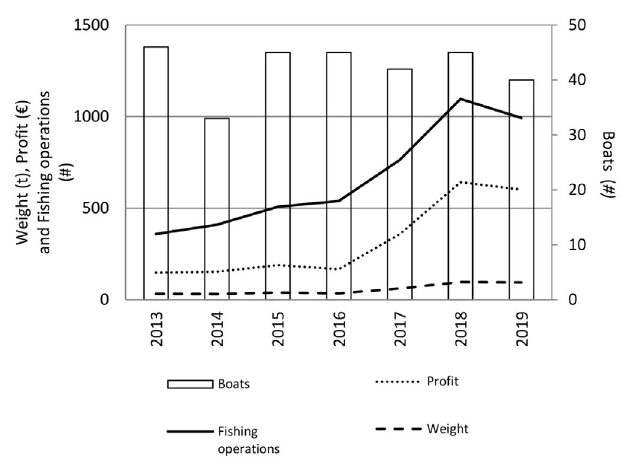
Fig. 2. – Evolution of total caught weight, total profit and fishing operations of the RAM artisanal fleet for each year considered